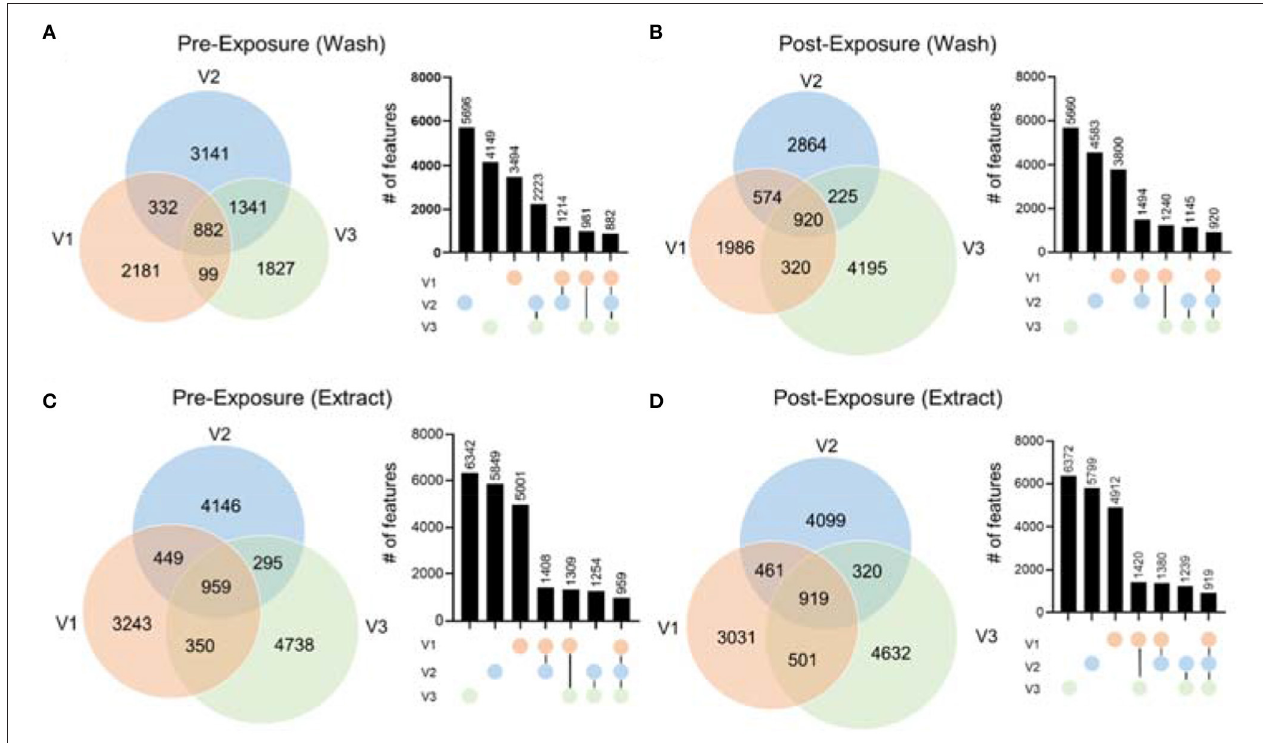
FIGURE 5 | The comparison of metabolic features in hair extract and hair wash of the three volunteers before and after exposure in RP( + ) mode. The Venn diagrams include (A) hair wash of pre-exposure; (B) hair wash of post-exposure; (C) hair extract of pre-exposure; (D) hair extract of post-exposure. Column plots next to each Venn diagrams illustrate the number of features in each area of the Venn diagram in the order from high to low.